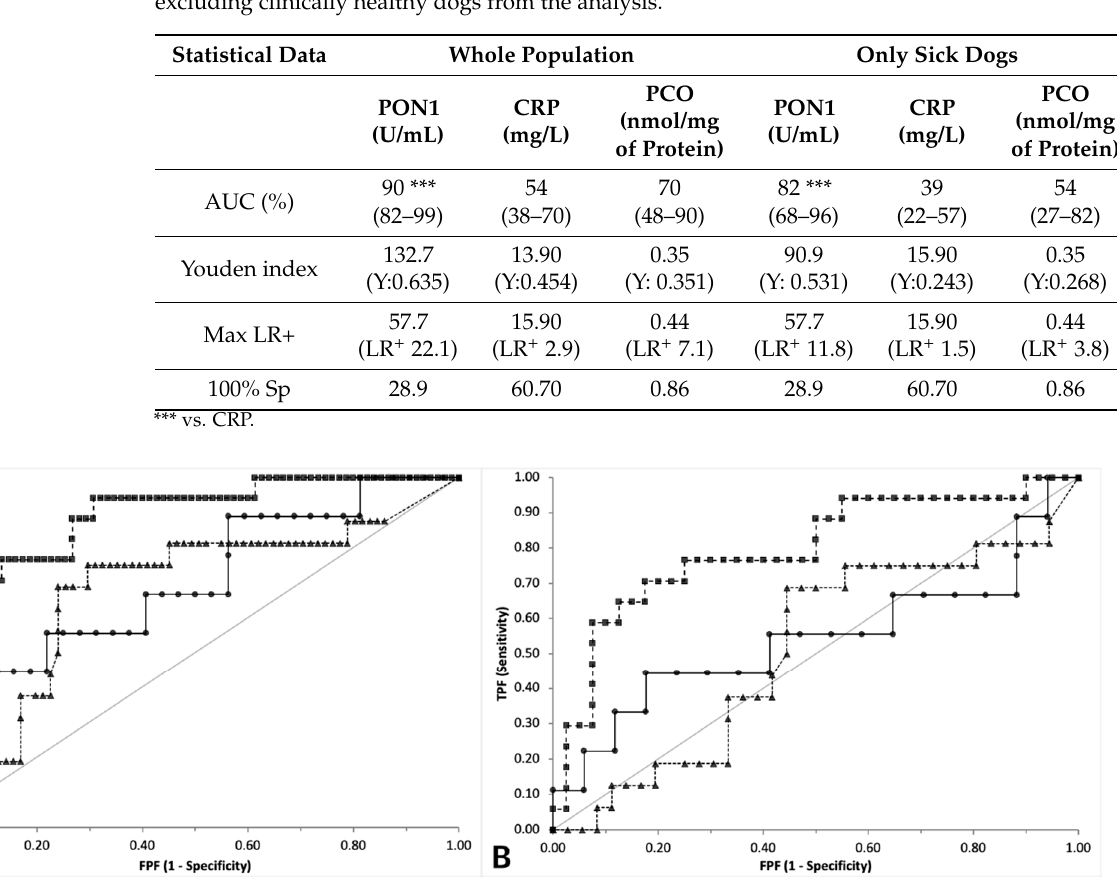
Figure 5. Comparison of ROC curves to support a poor outcome designed for PCO (black circles, continuous line), CRP (black triangles, dotted line) and PON1 (black squares, dashed line). The graph on the left ( A ) includes the results of the three groups of dogs, the graph on the right ( B ) includes only the results of dogs with sepsis or trauma. The grey line indicates the line of no discrimination. TPF = true positive fraction; FPF = false positive fraction.